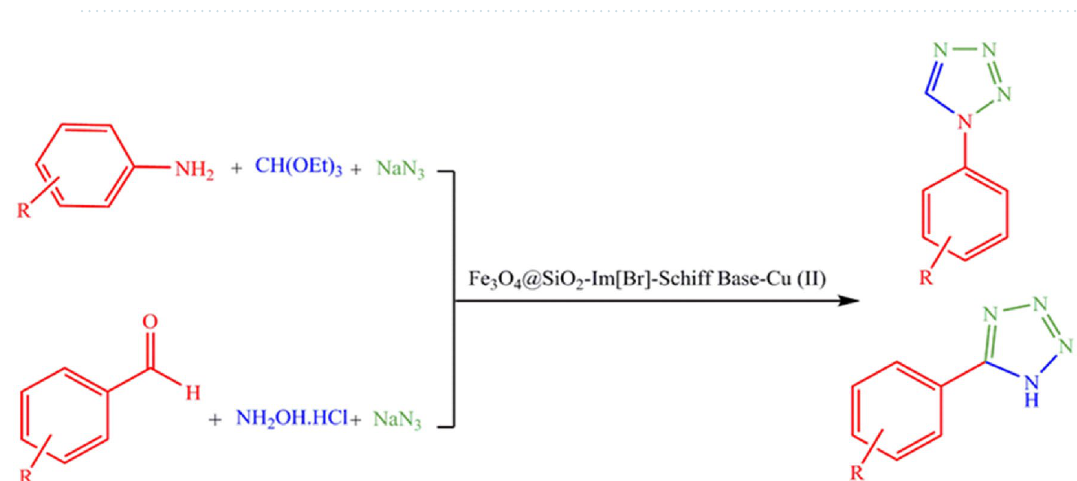
Figure 2. Synthesis of the tetrazole derivatives in the presence Fe 3 O 4 @SiO 2 -Im[Br]-SB-Cu (II)